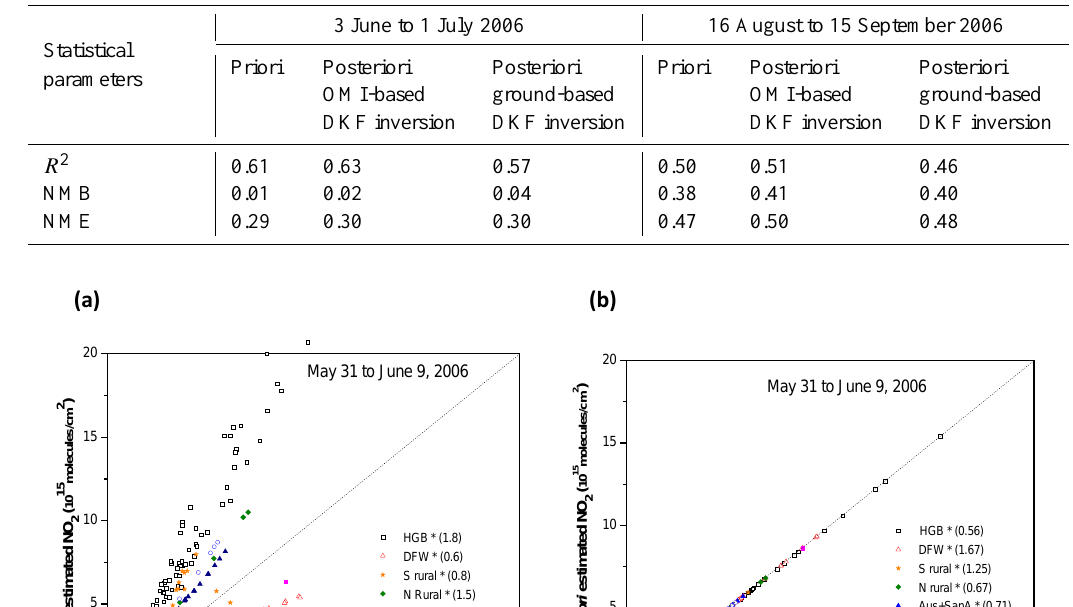
Table 6. Performance of CAMx in simulating AQS hourly ground-level O 3 .